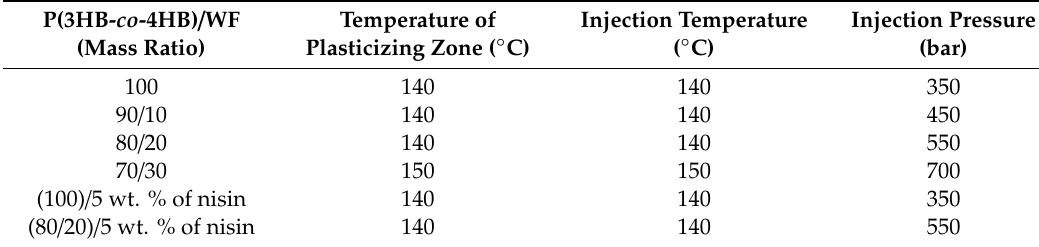
Table 1. Processing parameters of